Question: In a single sentence, describe what this figure presents.
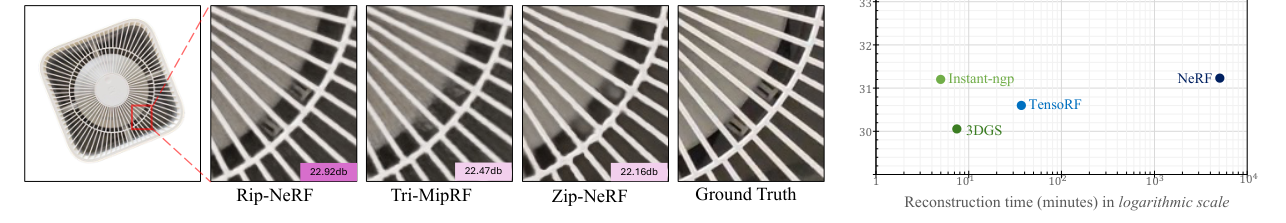
Answer: Qualitative and quantitative results of our Rip-NeRF and several representative baseline methods, e.g., Zip-NeRF [Bar- ron et al. 2023], Tri-MipRF [Hu et al. 2023], etc. Rip-NeRF25k is a variant of Rip-NeRF that reduces the training iterations from 120𝑘to 25𝑘for better efficiency. The first and second rows in the left panel are results from the multi-scale Blender dataset [Barron et al. 2021] and our newly captured real-world dataset, respectively. Our Rip-NeRF can render high-fidelity and anti-aliasing images from novel viewpoints while maintaining efficiency.